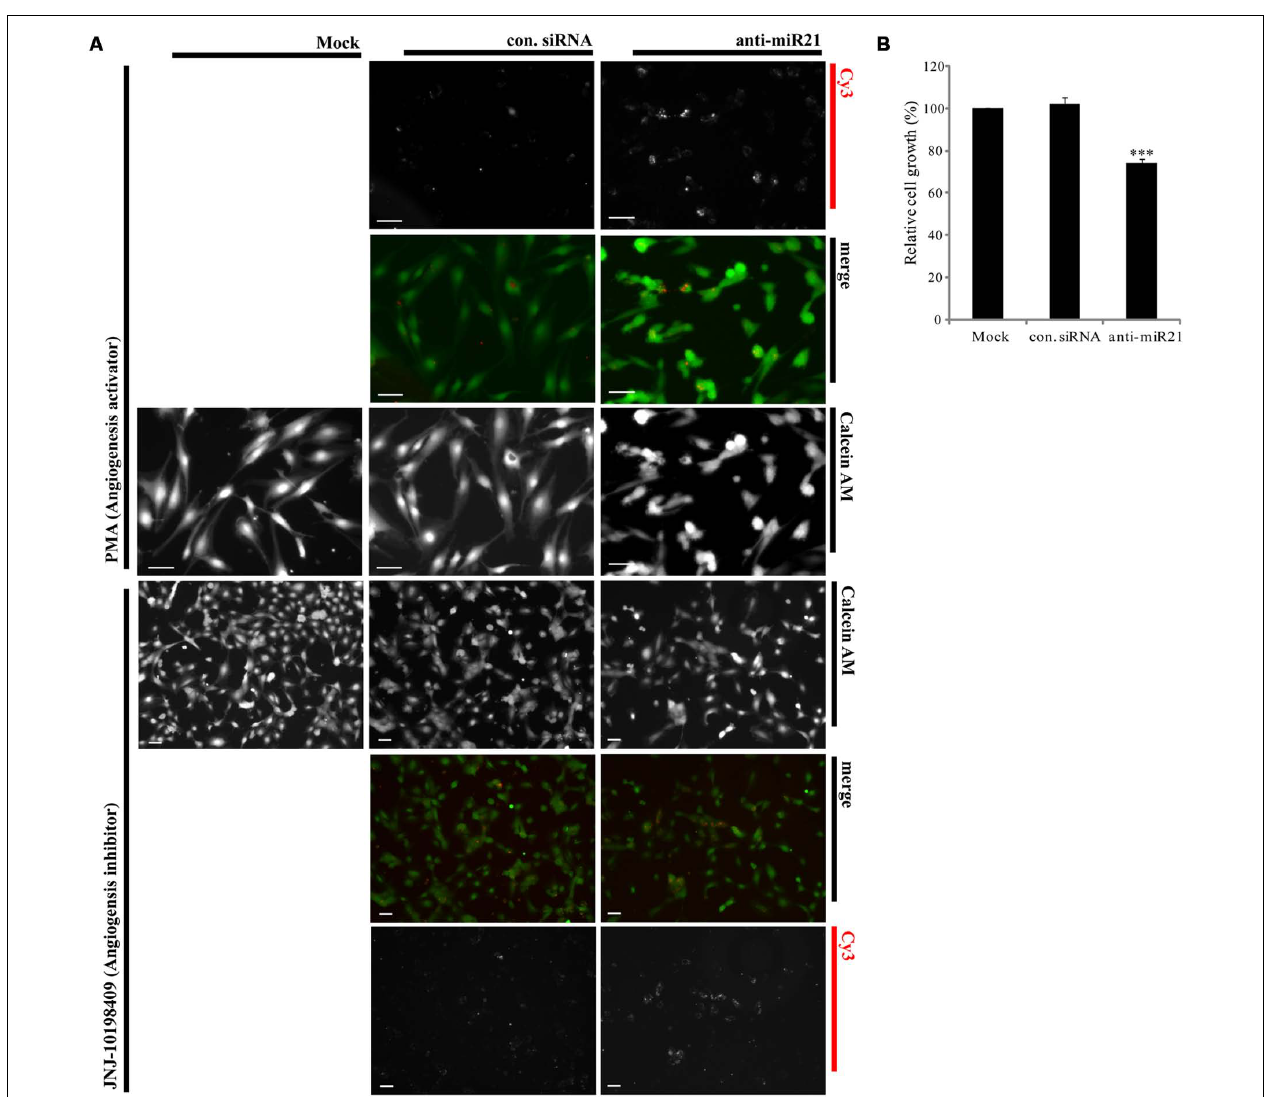
in red.The picture was taken by Zeiss AxioVert 200 inverted microscope. Scale bars, 50 μ m (B) Relative cell growths of HCT116-GFP cells that were transiently transfected with negative control siRNA or anti-miR21 (5 nM).The cells were allowed to grow for 2 days before MTS assay.Values are means of four experiments ± SD. ∗∗∗ p < 0.005 versus